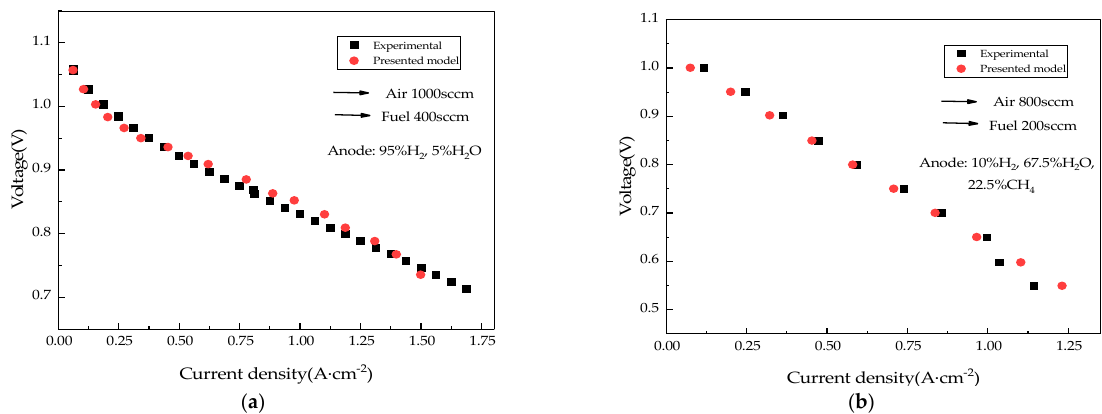
Figure 2. The comparison of the predicted V–I curve from model with experimental data at the same condition. ( a ) H 2 -SOFC; ( b ) CH 4 -SOFC [27]. To further validate the accuracy of the model by calculating the root mean square error (RMSE) between each experimental point and the simulated point in Figure 2. The calculated root mean square error of H 2 − SOFC and CH 4 − SOFC are 5.6% and 4.5%, respec- tively. RMSE can be calculated by Equation (29).